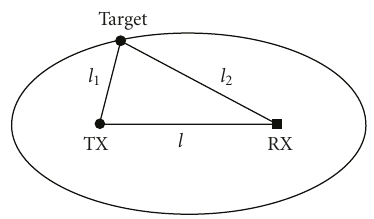
Figure 2: Equi-TOA positions (ellipse) in a bistatic